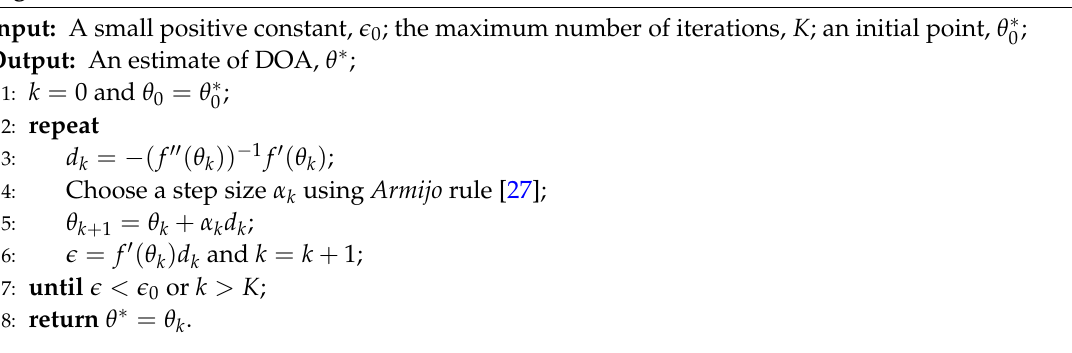
Algorithm 1 The Procedure of One-Dimensional Newton’s Iteration.